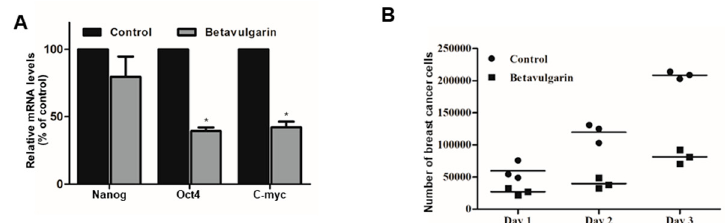
Figure 6. Effects of betavulgarin on the expression of BCSC marker genes and mammosphere growth. ( A ) Real-time qPCR analysis of the Nanog, c-Myc, and Oct4 genes in mammospheres, after treatment with betavulgarin for 46 h. ( B ) Mammosphere growth was inhibited by betavulgarin. Mammospheres with/without betavulgarin were divided into single cells and plated in 6-well plates in equal numbers. One, days 2 and 3, the cells were counted. The data from triplicate experiments are represented as the mean ± SD. * p < 0.05 versus the DMSO-treated control group.